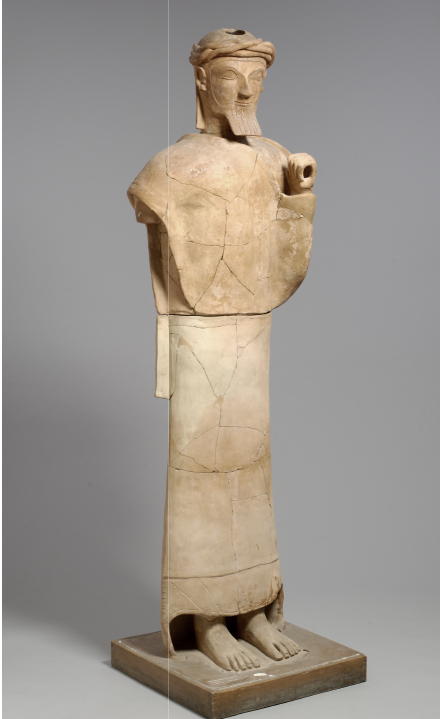
Figure 3. Terracotta male statue wearing a turban-like headdress, A.I. 2072+2075, ©